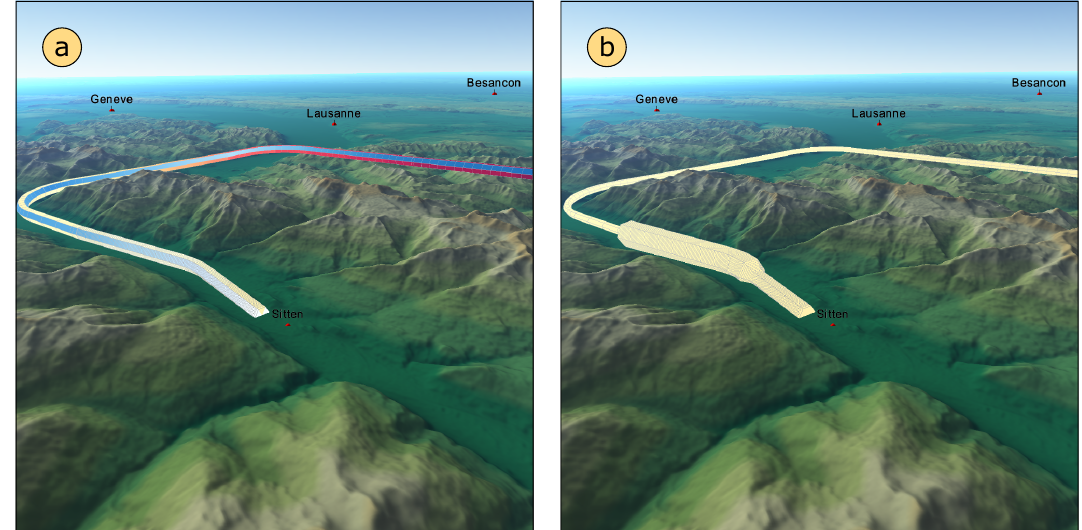
Figure 12. Communicating further details of the trajectory. The image on the left ( a ) depicts two parameters encoded into color: wind speed (yellow to red) and the amount of cross wind (light blue to dark blue). The image on the right ( b ) shows outliers in fuel consumption along the path by the width of the trajectory (greater width means larger fuel